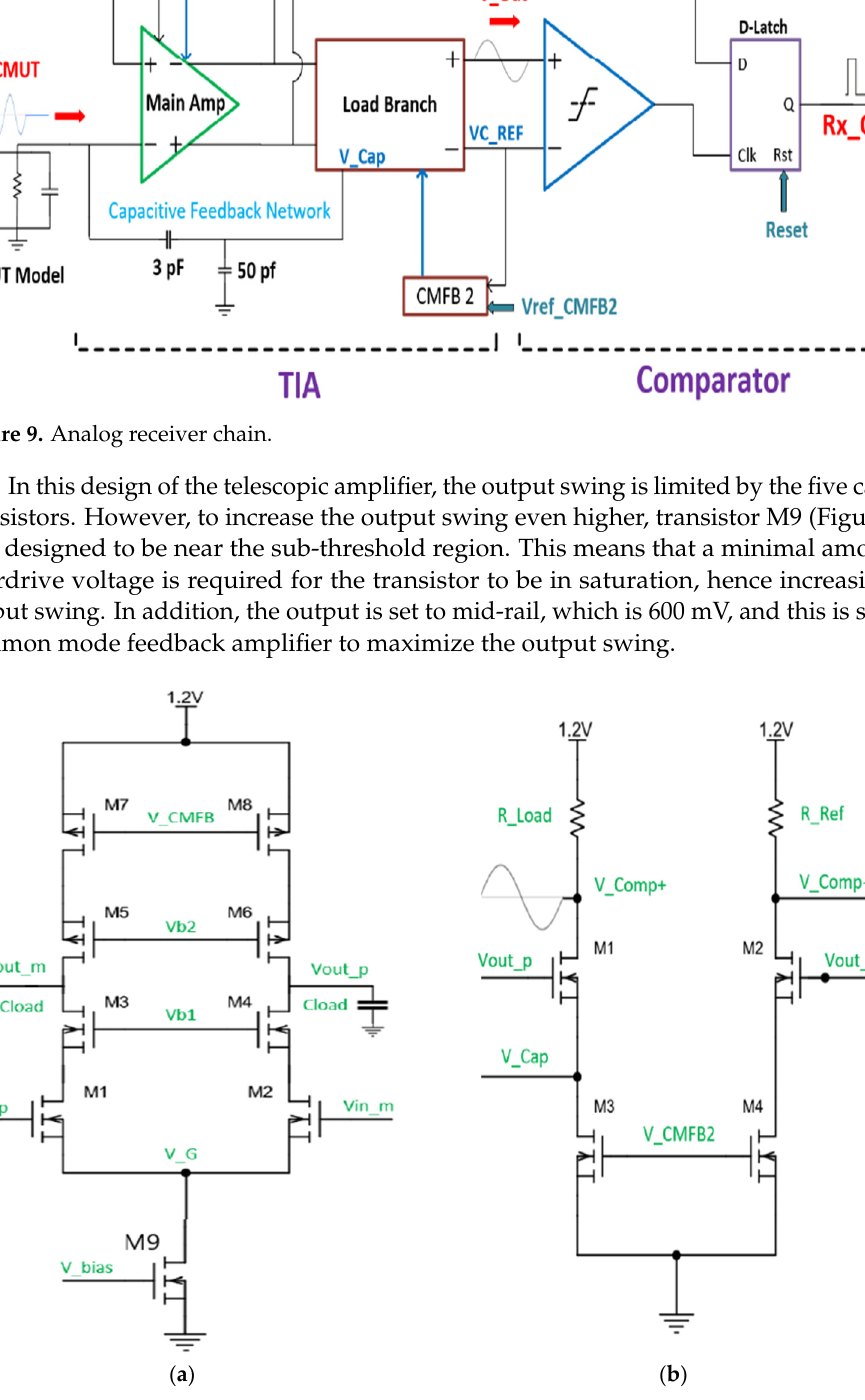
Figure 10. ( a ) Telescopic operational transconductance amplifier. ( b ) Load branch.